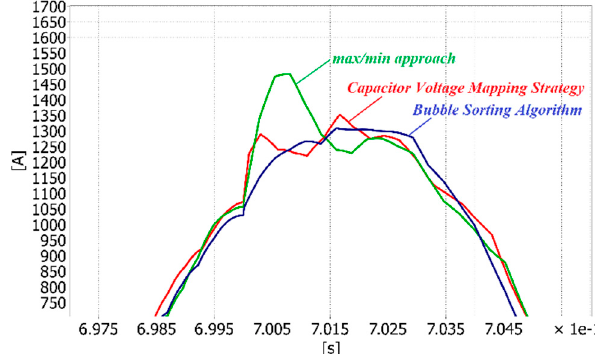
Figure 8. Zoom of the output currents of the upper arm in phase a and during phase to ground fault. Blue line: Bubble sorting algorithm. Green line: Max/min approach. Red line: Proposed mapping strategy.